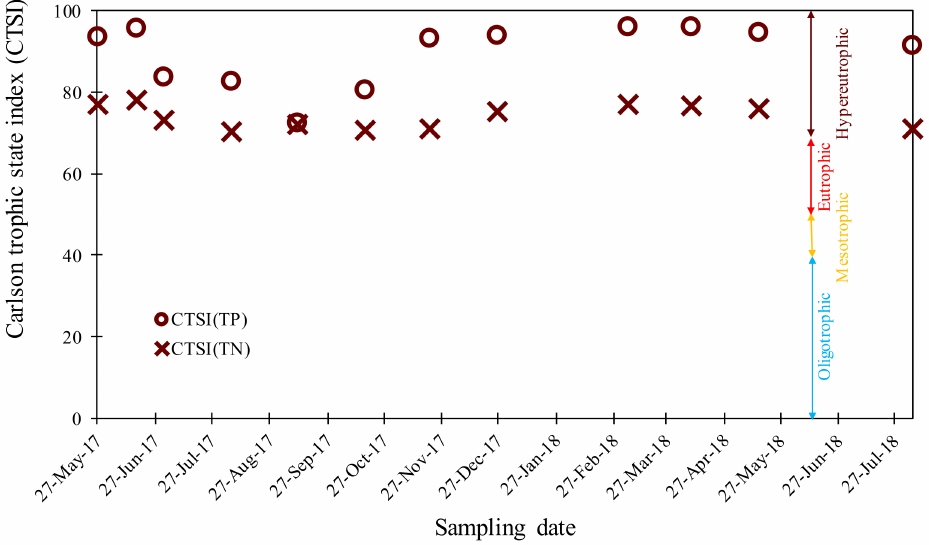
Figure 4. TP- and TN- based Carlson trophic state indices (CTSI(TP) and CTSI(TN)) calculated for mean values of TP and TN measurements in the epilimnion (at the depths of 0.5, 3, and 6 m) during each sampling